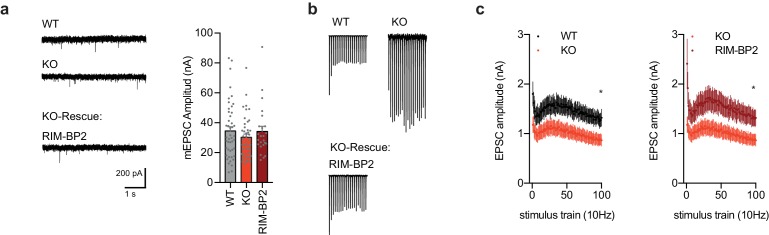
Loss of RIM-BP2 increases synaptic facilitation in autaptic granule neurons.Sample traces of miniature EPSCs (mEPSCs) and summary graph of mEPSC amplitudes. (mEPSC WT (48/4); KO (37/4); RIM-BP2 (24/3)) (b) Sample traces of normalized EPSC amplitudes to the first EPSC and (c) summary graph of EPSCs elicited by a 10 Hz stimulation train (WT (54/3); KO (44/3); RIM-BP2 (18/3). Values represent mean ± SEM. For statistics please see Figure 5—figure supplement 2—source data 1.10.7554/eLife.43243.023Figure 5—figure supplement 2—source data 1.Statistics of data presented in Figure 5—figure supplement 2.